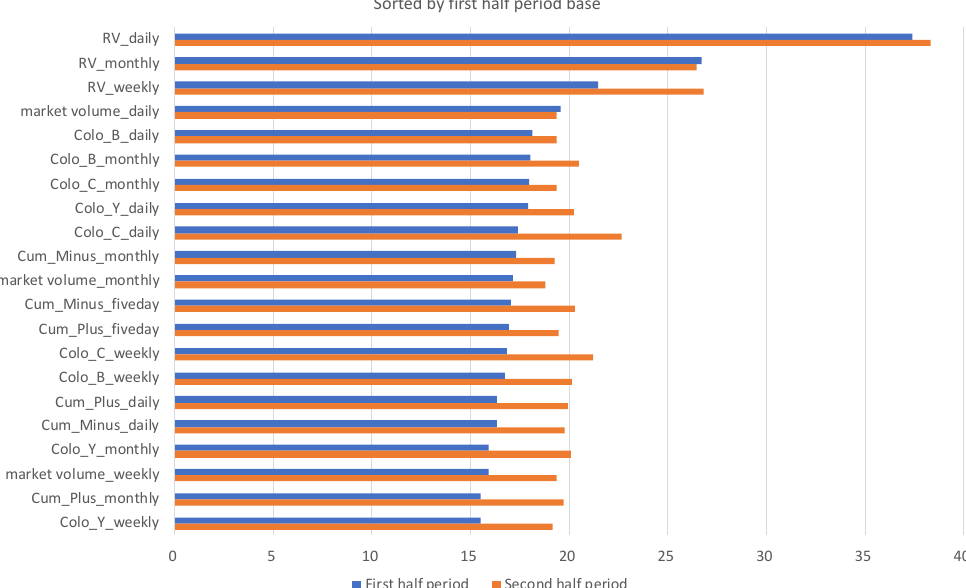
Figure 4. Importance variable changes from the first half period to the second half period sorted by first-half period base.